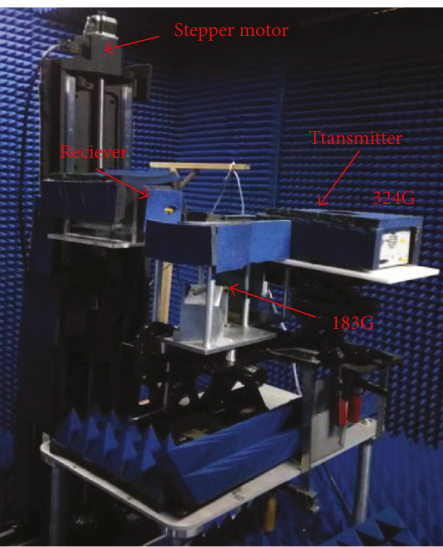
Figure 8: The planar near- fi eld measurement of dual-channel 3D QON